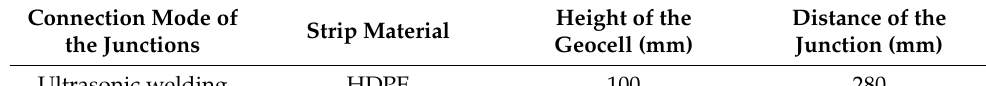
Table 1. Specifications of the geocell.